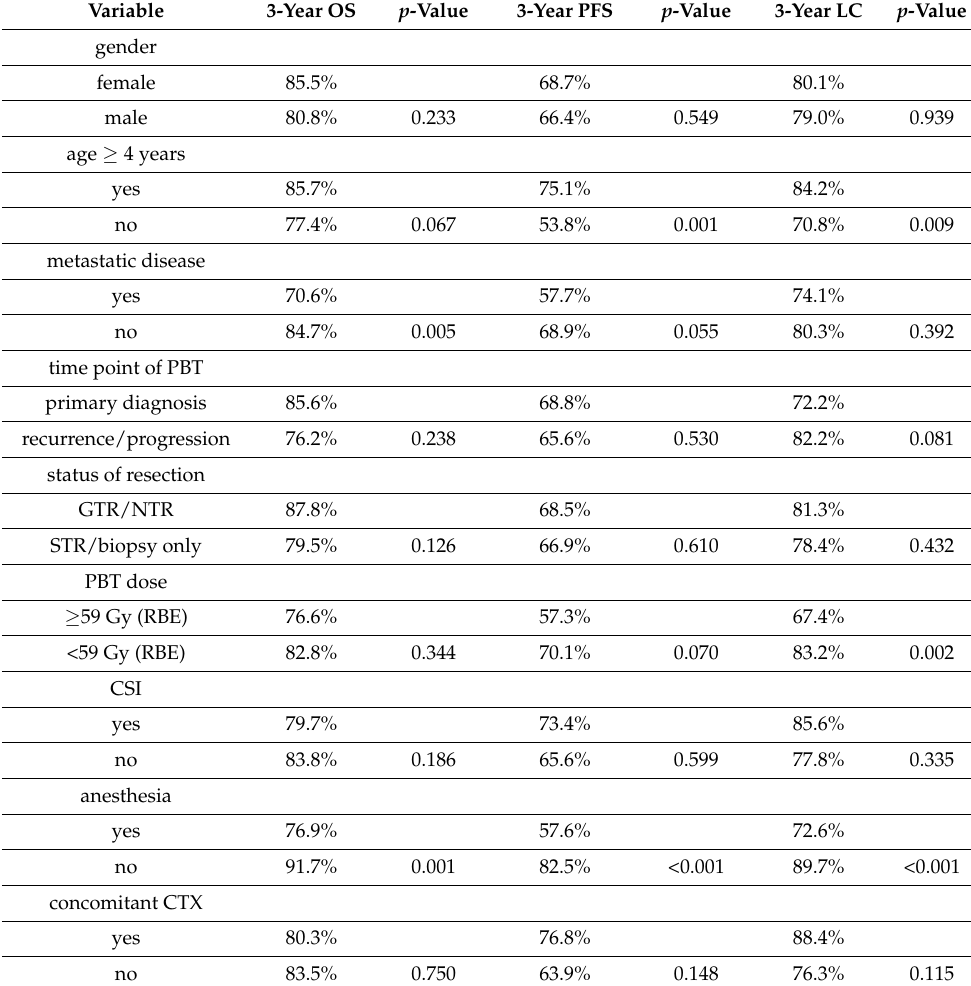
Table 3. Univariate analysis of risk factors for OS, PFS, and LC.